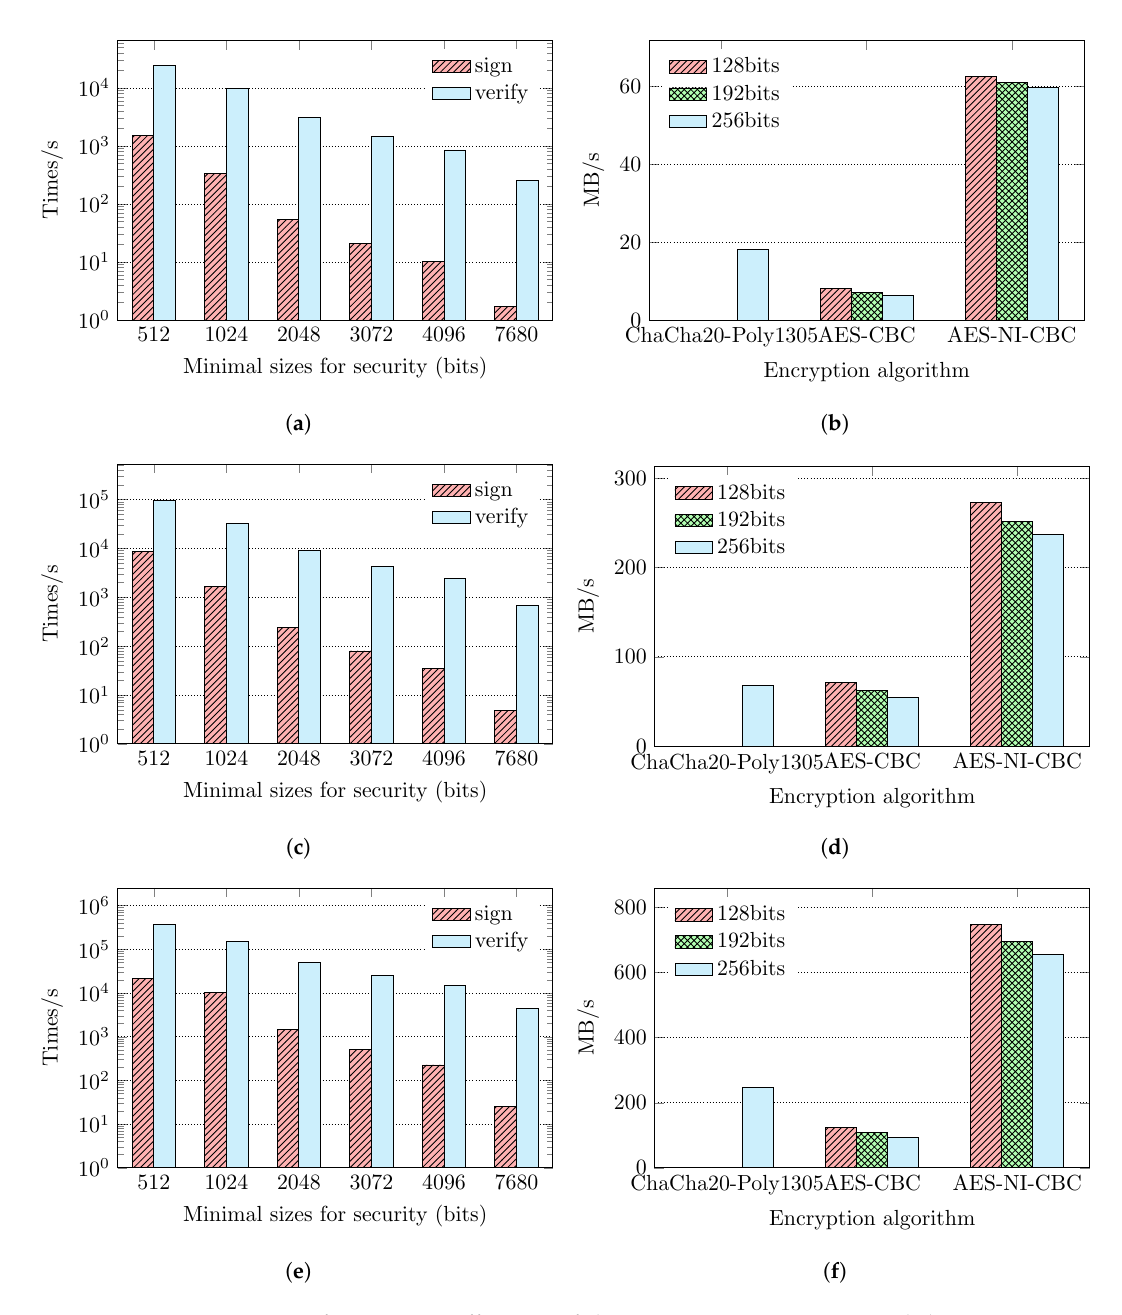
Figure 7. Comparison of encryption efficiency of the asymmetric encryption and the symmetric encryption algorithm in these platforms: Xilinx Zynq UltraScale+, FT-2000+: FTC662, and Intel Core i7-6700. ( a ) RSA in Xilinx Zynq; ( b ) AES in Xilinx Zynq; ( c ) RSA in FT-2000+: FTC662; ( d ) AES in FT-2000+: FTC662; ( e ) RSA in Intel Core i7-6700; ( f ) AES in Intel Core